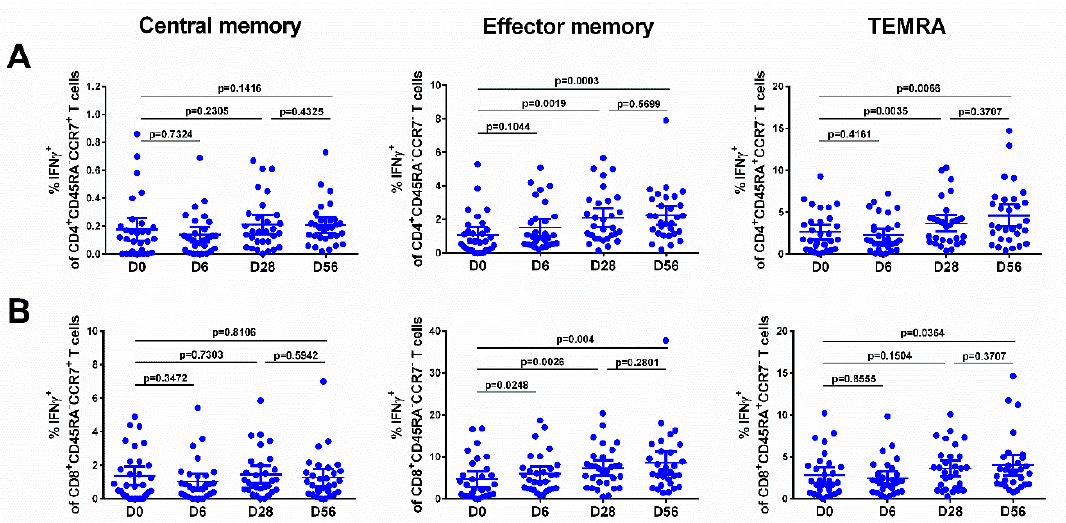
Figure 5. Different populations of IFN γ -producing CD4 + ( A ) and CD8 + ( B ) T cells in subjects immunized with H7N9 LAIV. Individual data are shown, along with means ± 95% CI. T cell levels at different time-points were compared using the Wilcoxon matched-pairs test.